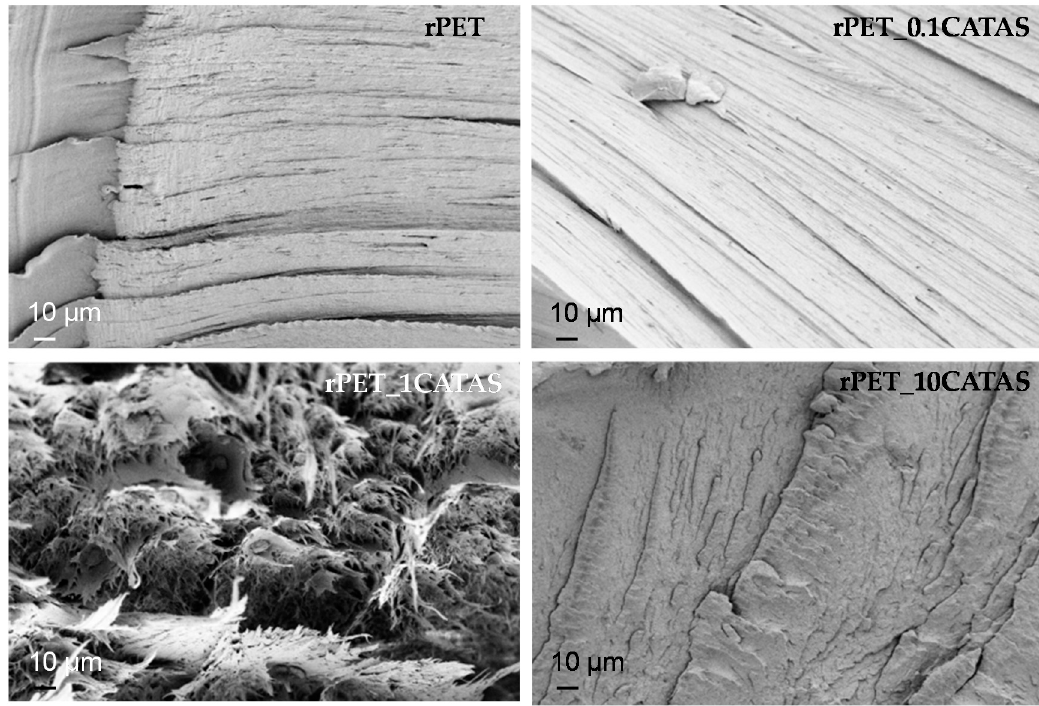
Figure 6. FESEM images of fractured surfaces for rPET and rPET/CATAS